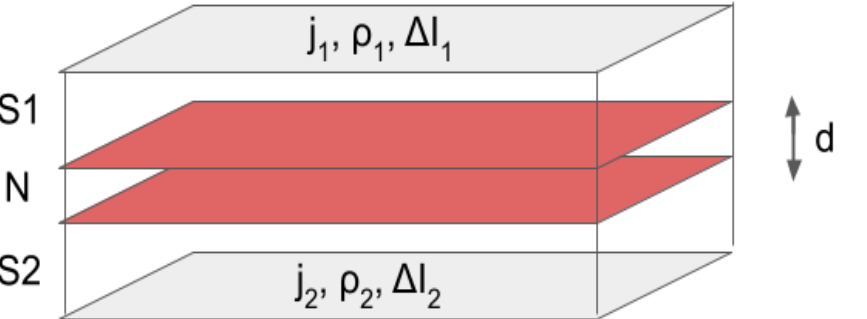
Figure 3. Tunneling Josephson junction of the SNS or SIS type, with an insulating layer of thickness d between two superconducting electrodes S1 and S2. ρ 1 and j 1 denote respectively the charge and current density on Electrode 1, and similarly for ρ 2 and j 2 . Due to the phase-number uncertainty principle, the classical local conservation relation I = ∂ t ρ + ∂ x j x = 0 cannot be exactly satisfied and there will be fluctuations ∆ I 1 and ∆ I 2 on the two electrodes, especially when the current in the junction is oscillating at high frequency. We suppose that the fluctuations are opposite in sign, so that the total charge is not